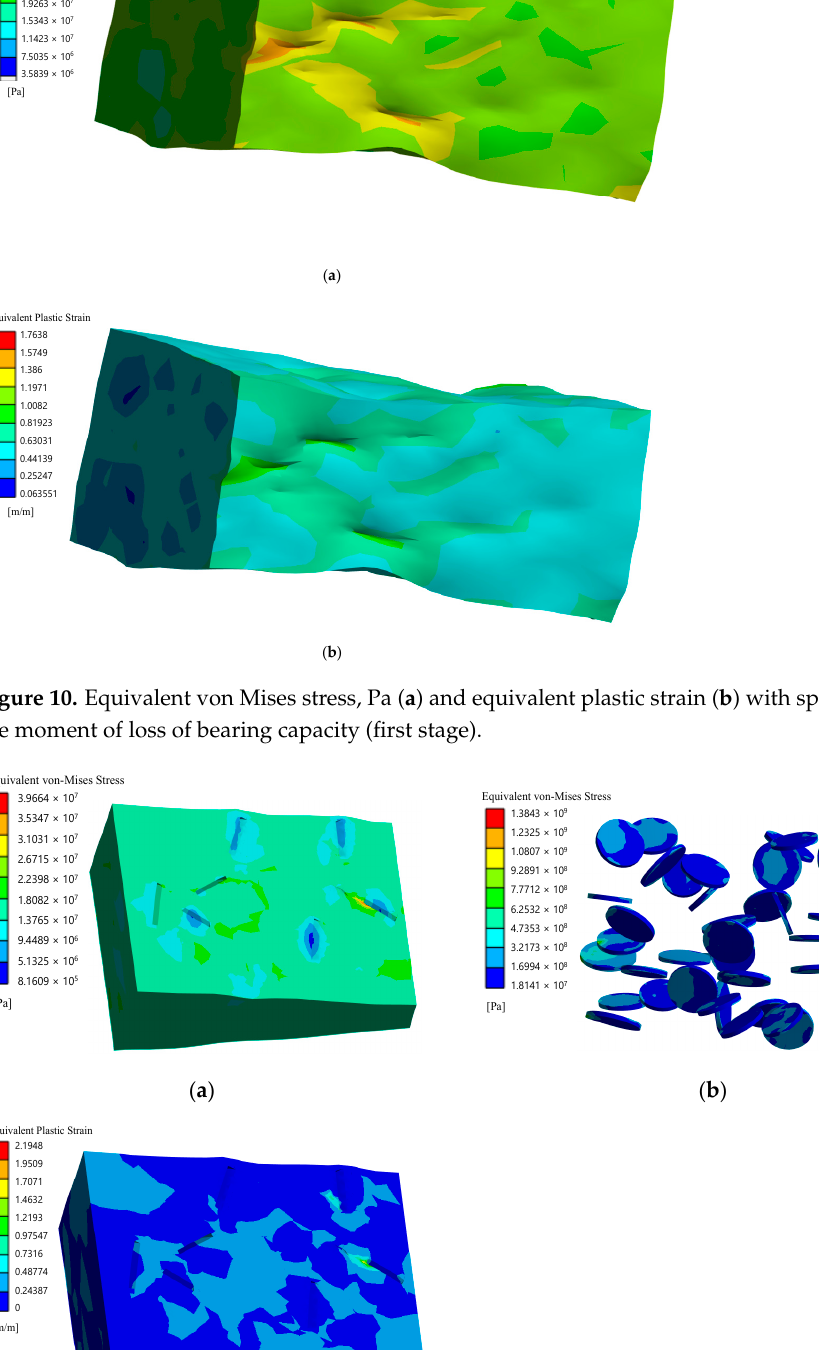
Figure 12. Stress– plastic strain ( a ) and stress– total strain ( b ) curves for composite with spherical filler (first stage). Figure 13. Stress– plastic strain ( a ) and stress– total strain ( b ) curves for composite with short cylin- drical filler (first stage).